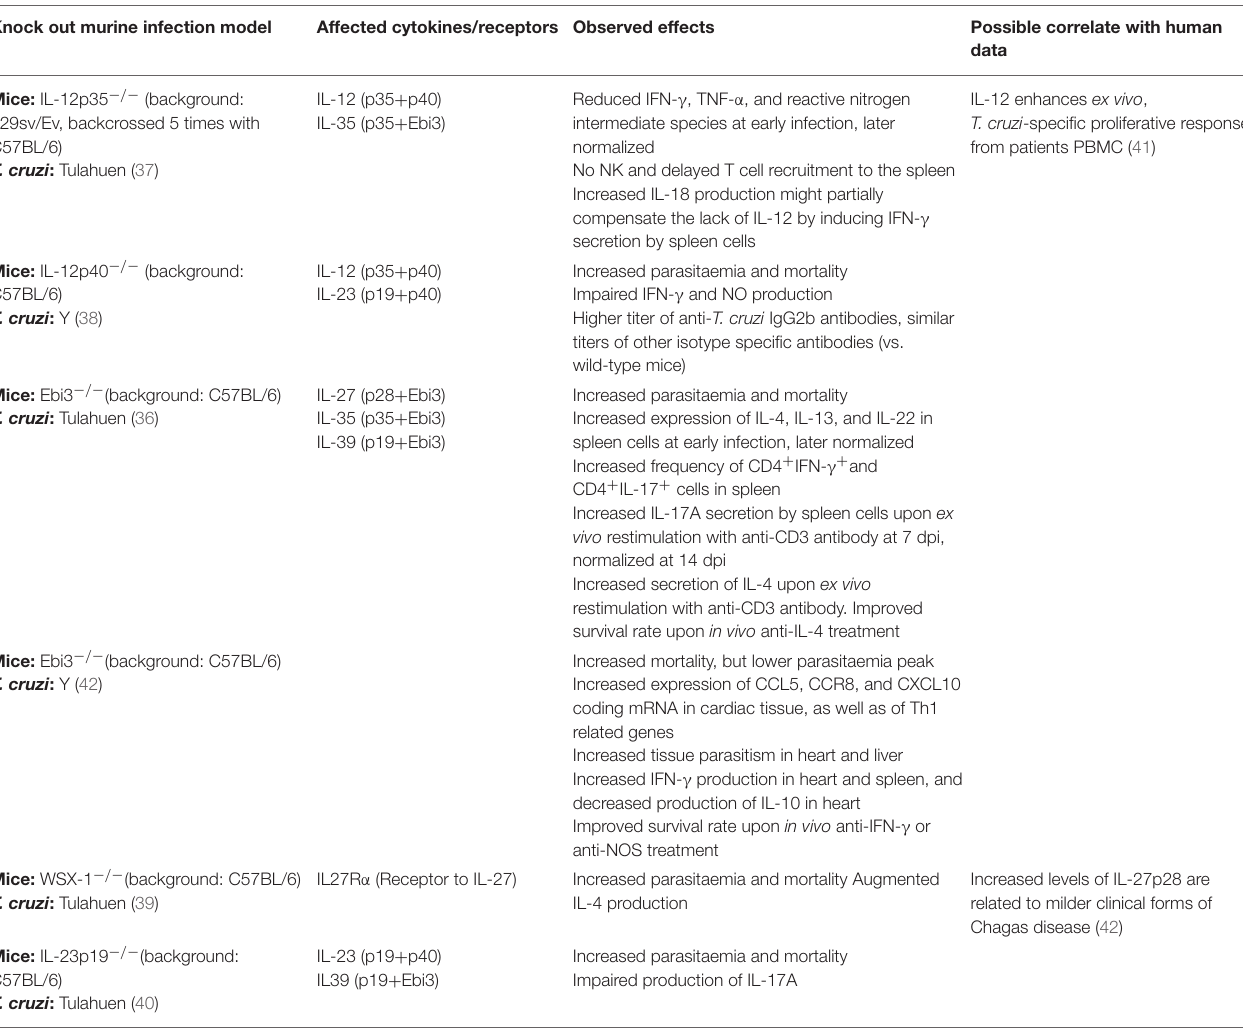
TABLE 1 | Effects of the IL-12 family cytokines in T. cruzi infection. Knock out murine infection model Affected cytokines/receptors Observed effects Possible correlate with human